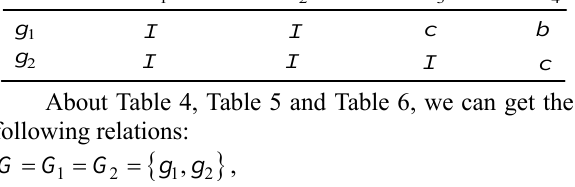
Table 6 ． A lattice-valued formal context